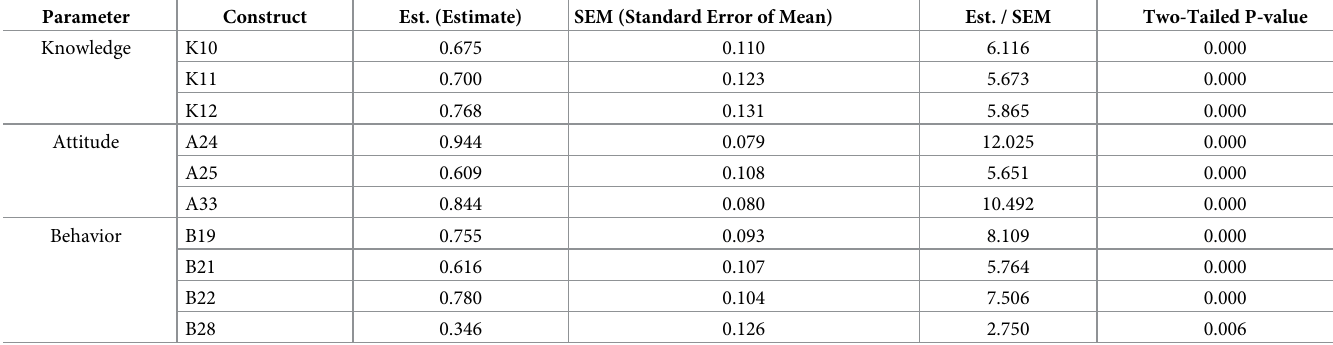
Table 2. Item loadings and validities for reliability test and convergent validity.